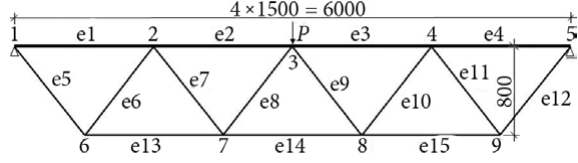
Fig. 12. General layout of test